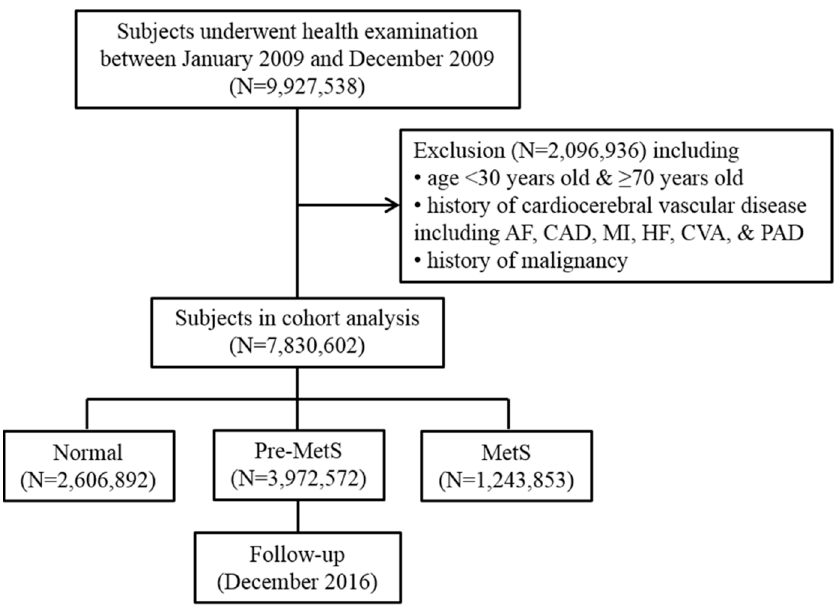
Figure 1. Flow diagram of the study population. AF indicates atrial fibrillation; CAD, coronary artery disease; CVA, cerebrovascular accident; HF, heart failure; MetS, metabolic syndrome; MI, myocardial infarction; and PAD, peripheral artery disease.